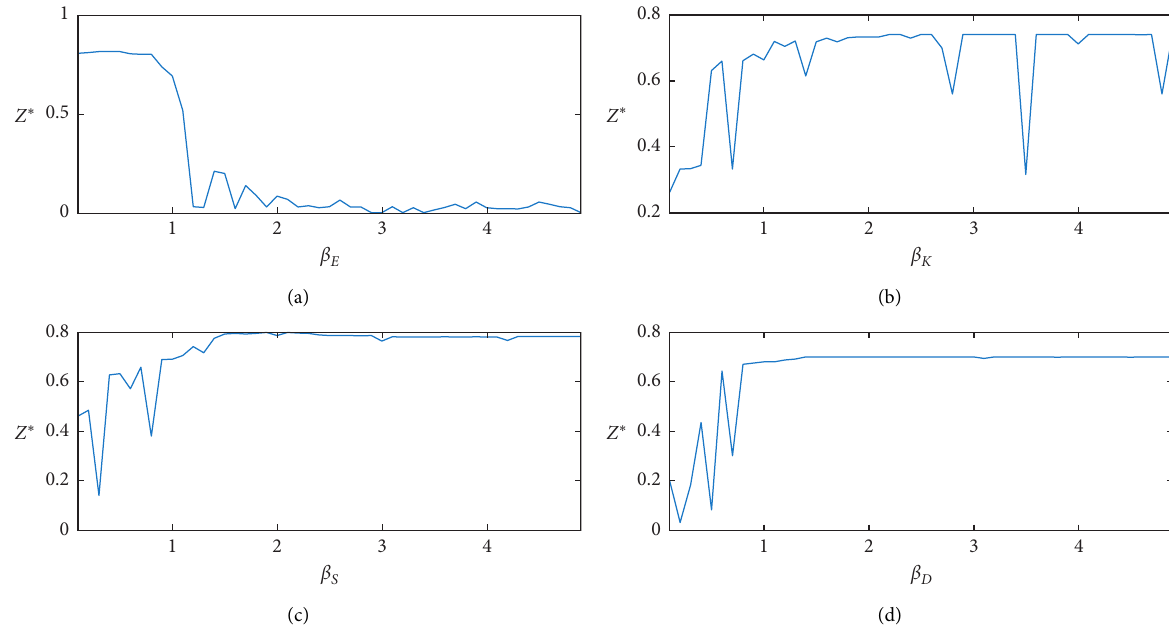
Figure 7: Effects of β